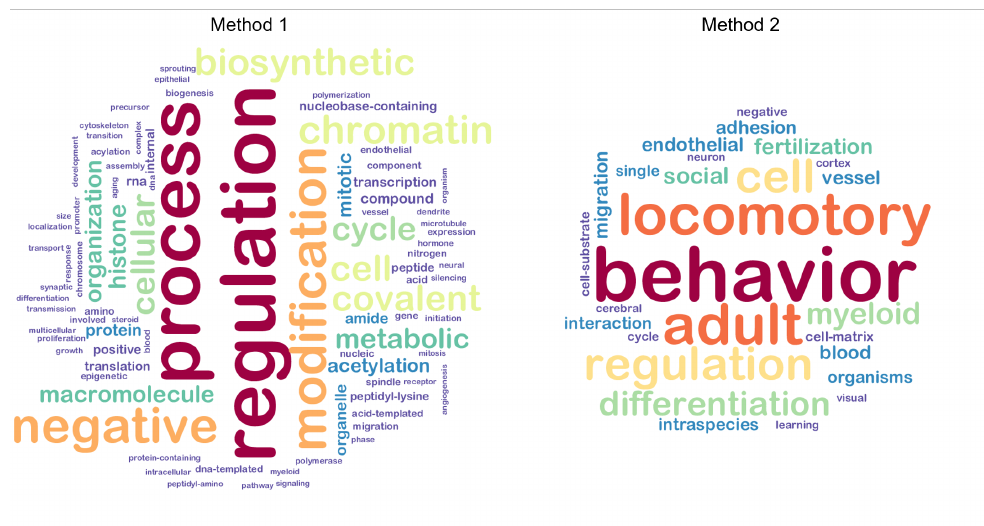
Figure 8. Word clouds for GO terms related to up-regulated genes. The word clouds show the top 100 words retrieved using the procedure described in Figure